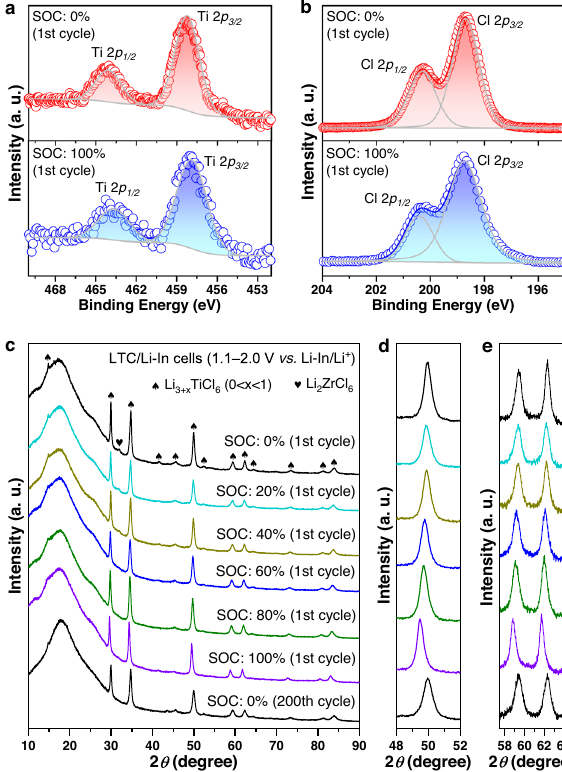
Fig. 8 | Li-ion storage mechanism of the LTC positive electrode based on the Ti 2+ /Ti 3+ redox couple. a , b Ex situ Ti-2 p ( a ) and Cl-2 p ( b ) X-ray photoelectron spectraofthe LTCpositive electrodein the Li-In | LPSCl | LZC|LTC cell atdifferent SOCsofitsinitialdischarge(thecorrespondingvoltagepro fi lewithSOCsindicated is displayed in Supplementary Fig. 11). c Ex situ XRD patterns of the LTC positive electrode from the Li-In | LPSCl | LZC|LTC cells at different SOCs. d , e Close-up viewsoftheXRDpatternsin c .ThedataforeachSOCisplottedinthesamecoloras that in c .